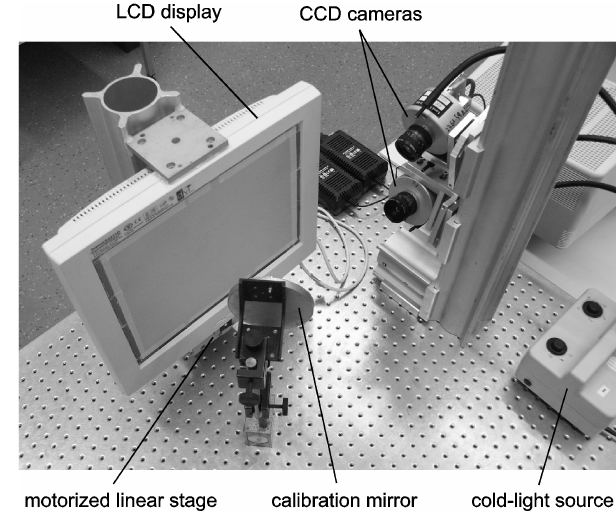
Figure 1. Ambiguity of determination of position and orientation of a mirror element in deflectometry (Tutsch et al., 2011).